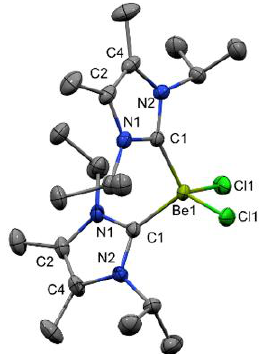
Figure 1. Molecular structure of 1 (thermal ellipsoids at 50% probability; H atoms and toluene solvent molecules omitted for clarity). Selected bond distances (Å) and angles (deg): Cl1−Be1: 2.0445(19); C1−Be1: 1.849(3); N1−C1: 1.367(2); N1−C2: 1.397(2); C2−C4: 1.354(3); N2−C4: 1.397(2); N2−C1: 1.357(2).